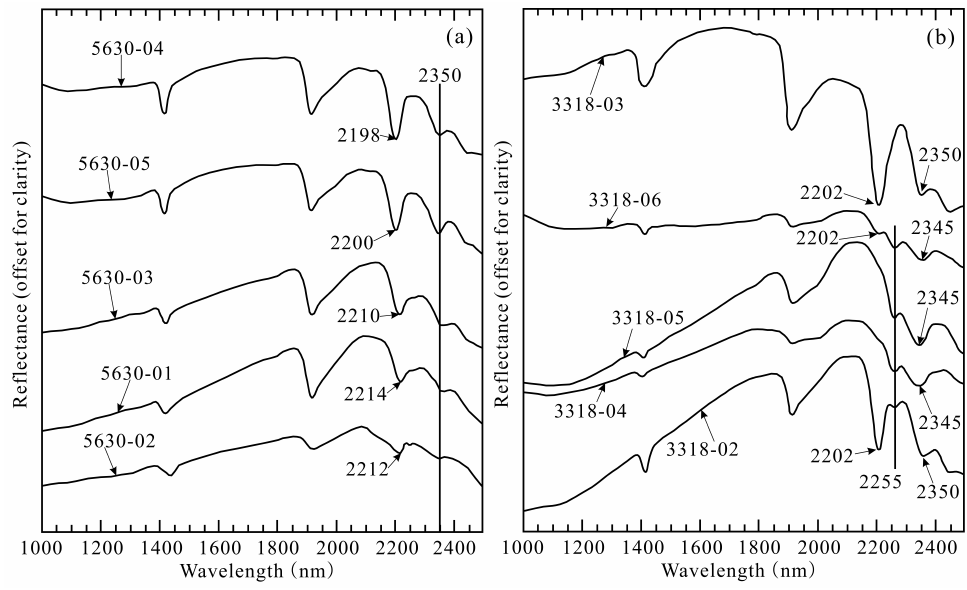
Figure 12. ( a ) Spectral curves (1000–2500 nm) of the samples 5630-01–5630-05 from ZK5630-1. ( b ) Spectral curves (1000–2500 nm) of the samples 3318-02–3318-06 from